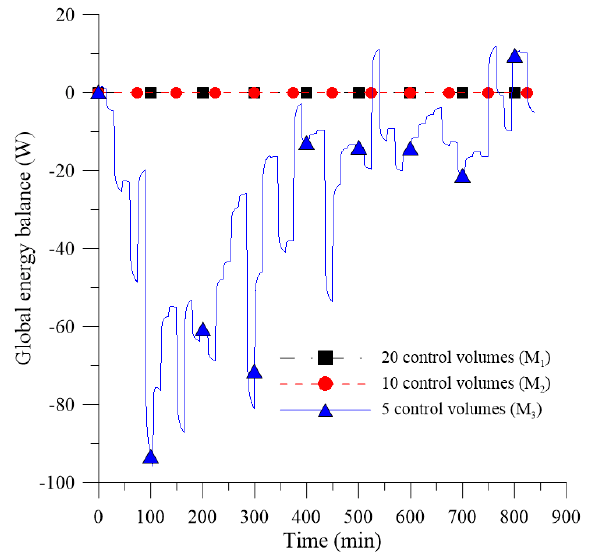
Figure 17. Global energy balance in thermal insulation as a function of time for different meshes.